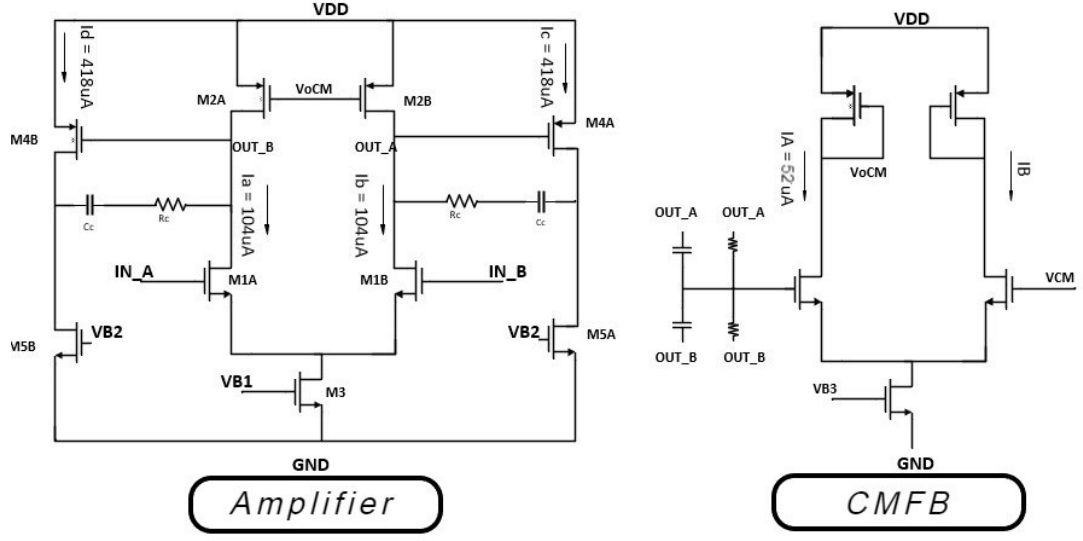
Figure 5. Shaper operational amplifier transistor-level